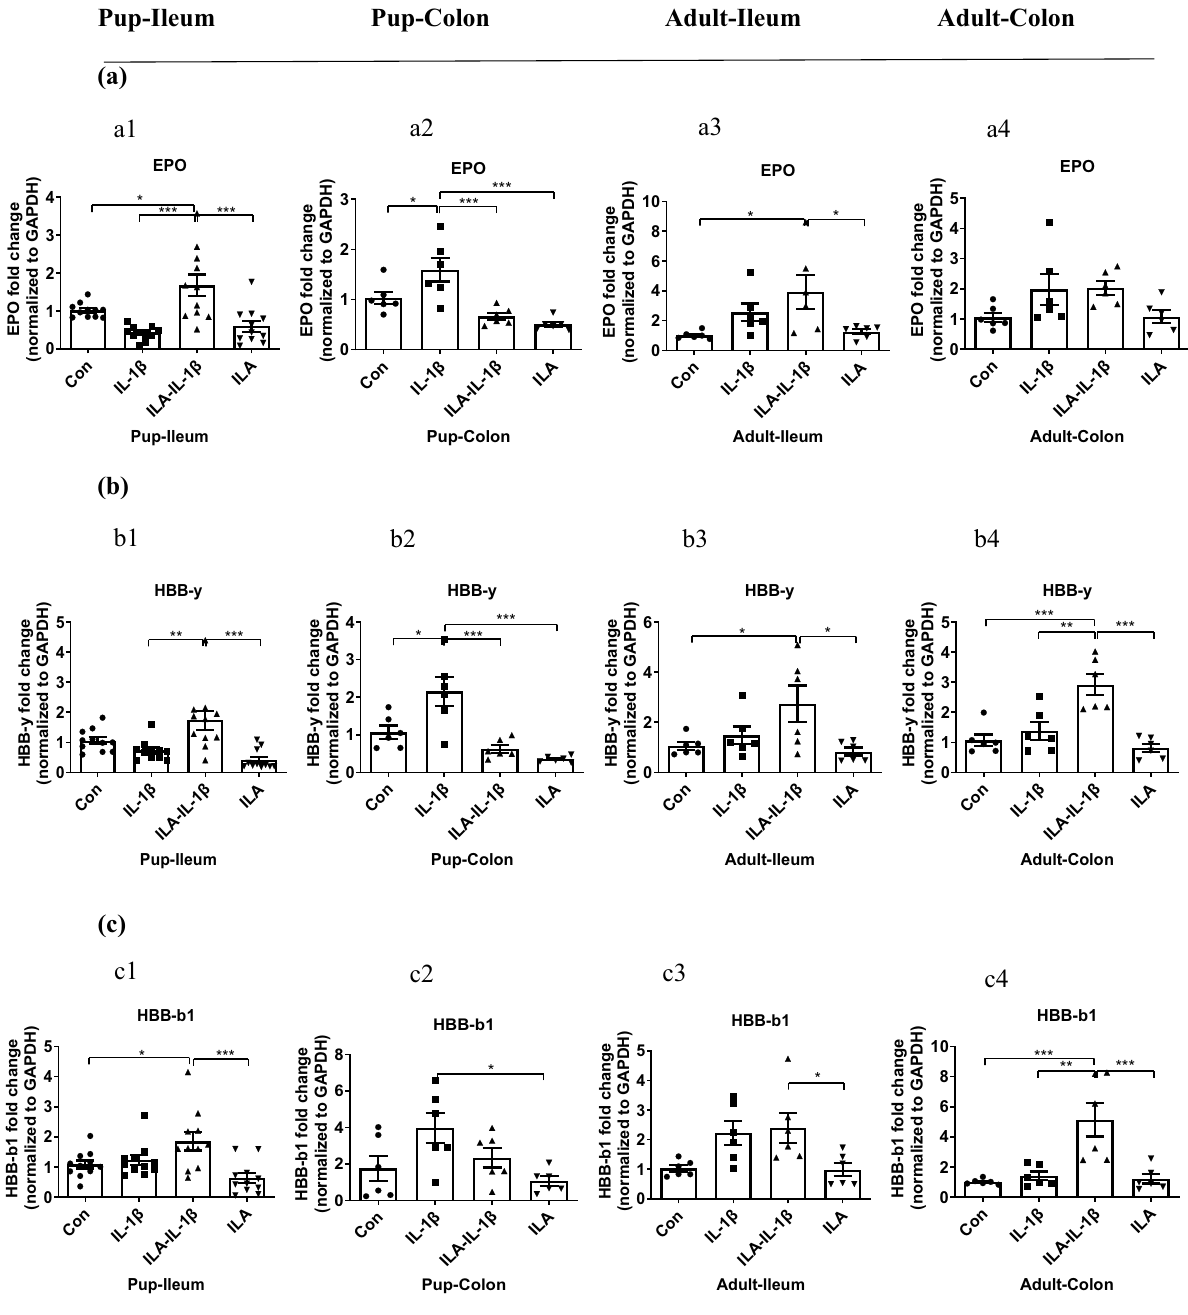
Figure 3. ILA affects potential anti-inflammatory gene expression in a range different and age different manners in mice intestine. ( a ) EPO, ( b ) HBB-y (beta-like embryonic chain), and ( c ) HBB-b1(adult major chain) mRNA gene expression level of qRT PCR in ileum (a1, b1, and c1) and colon (a2, b2, and c2) of pups; and ileum (a3, b3, and c3) and colon (a4, b4, and c4) of adults. Pup or adult mice were fed with or without ILA, whose intestinal tissues were incubated with or without IL-1β stimulation. Data are represented as the mean ± SEM (n = 6). One-way ANOVA and Tukey post hoc tests were used for statistical analysis. Differences were considered significant at * p < 0.05, ** p < 0.01, *** p < 0.001. EPO, erythropoietin; HBB-y, hemoglobin Y, beta-like embryonic chain; HBB-b1, hemoglobin, beta adult major